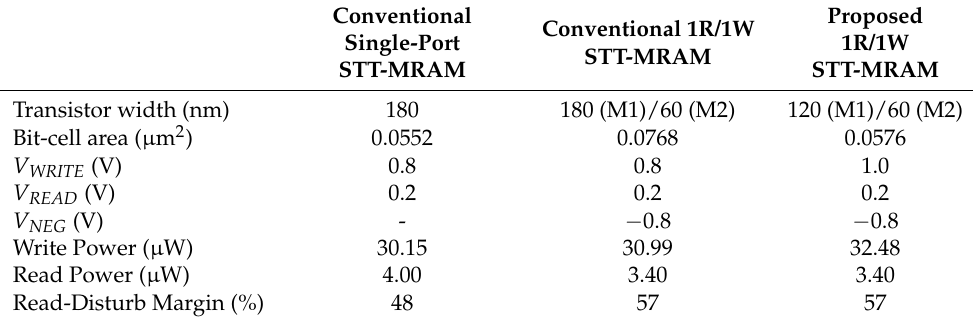
Table 2. Comparison of three different bit cells in terms of area, power, and read-disturb margin.